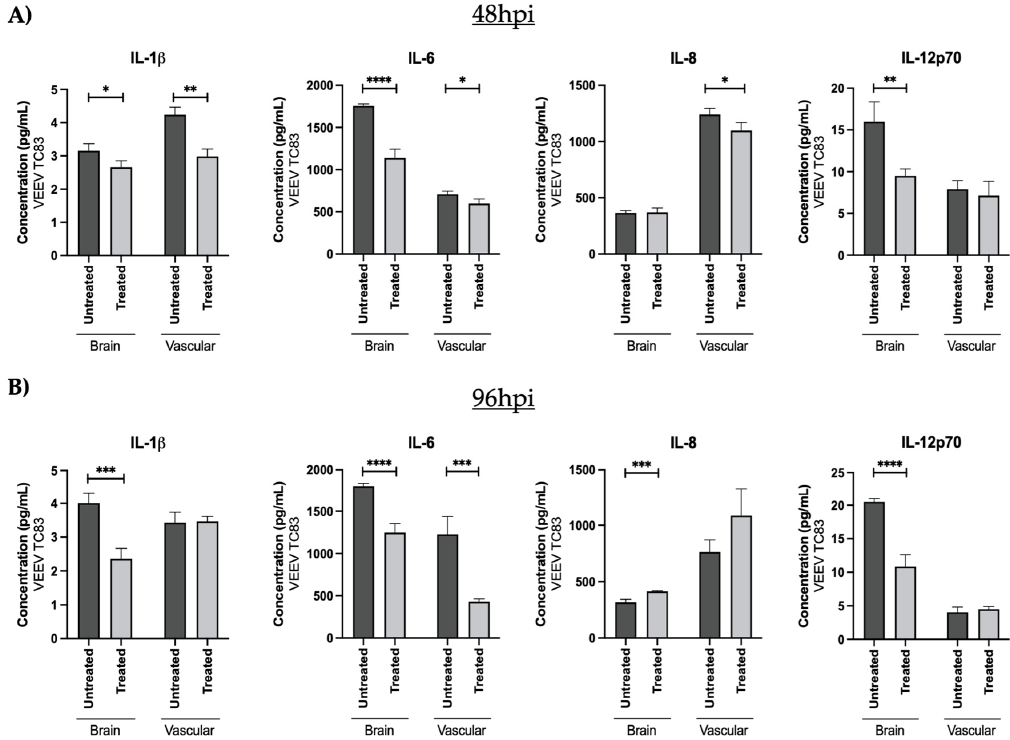
Figure 5. Quantification of proinflammatory cytokine load in the brain and vascular compartments of the gNVU following VEEV-C83 infection and treatment with OMA. The perfused media from the brain and the vascular sides of the gNVUs (infected, untreated [infected][n = 3], infected, treated [treated][n = 3] were collected at 48 h post infection ( A ) and 96 h post infection ( B ). The amounts of 10 proinflammatory cytokines were analyzed in these samples by multiplexed ELISA, of which data for 4 cytokines (IFN- γ , TNF- α , IL-1 β , IL-6, IL-8 and IL12-p70) are included. Each sample was included in the multiplexed ELISA as technical duplicates and the data were averaged for each analyte at each time point. The overall average of the biological replicates was obtained and represented as pg/mL concentration for each cytokine. Statistical analysis was carried out using t -test * p < 0.05, ** p < 0.01, *** p < 0.001, **** p <